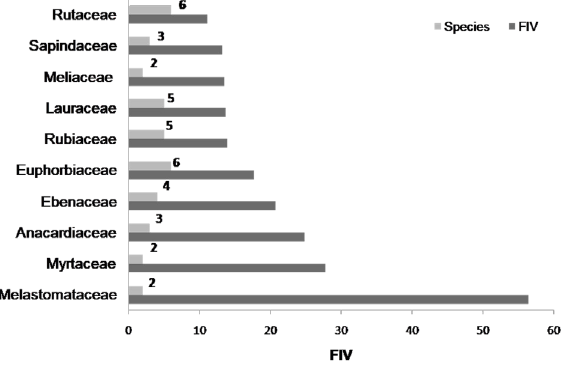
Figure 5. Family dominance based on FIV.